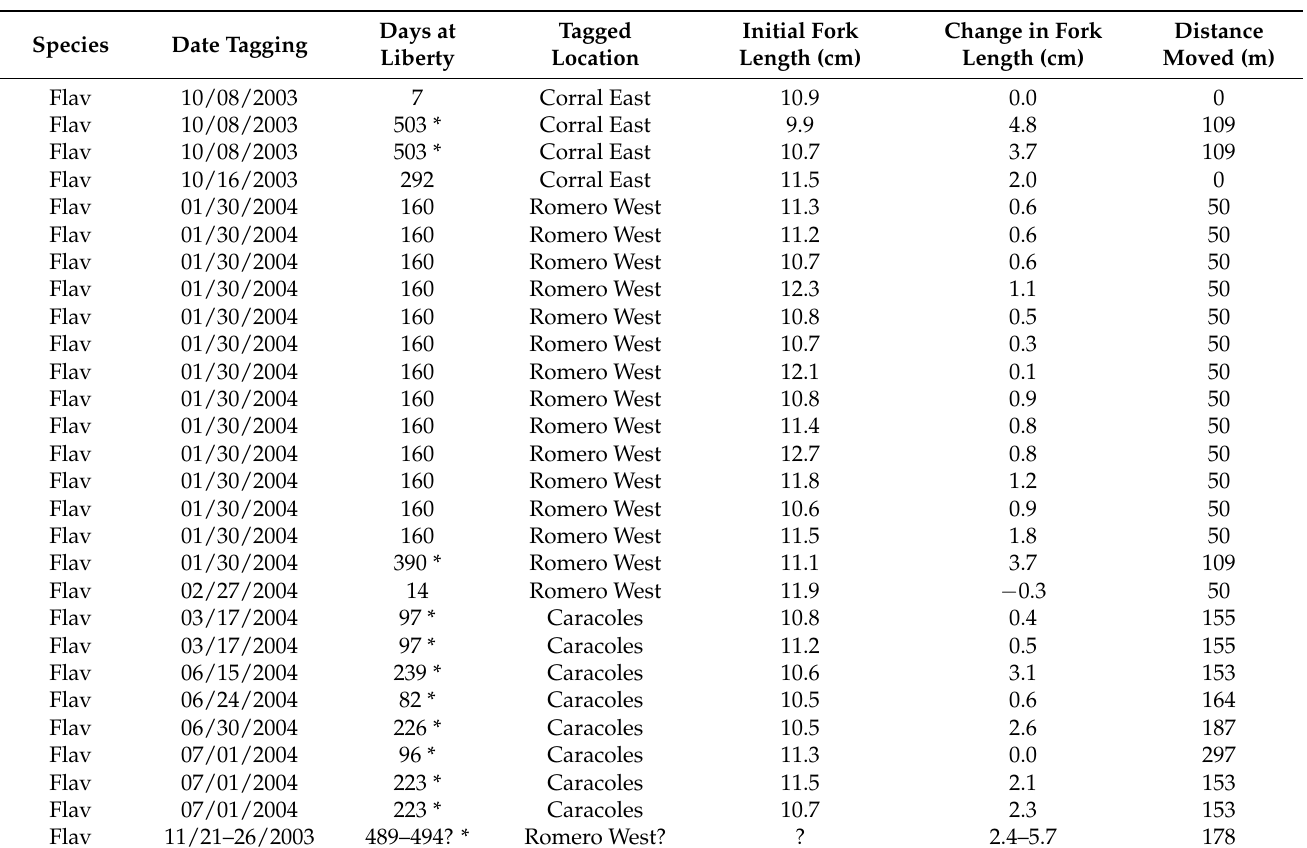
Table 6. Recovery data for ontogenetic movement of large-tagged juveniles of Haemulon flavolineatum (Flav) to adult habitat. Days at liberty with stars (*) denote fish recovered at a location other than the tagging location. ? indicates estimates based on a partial tag (see